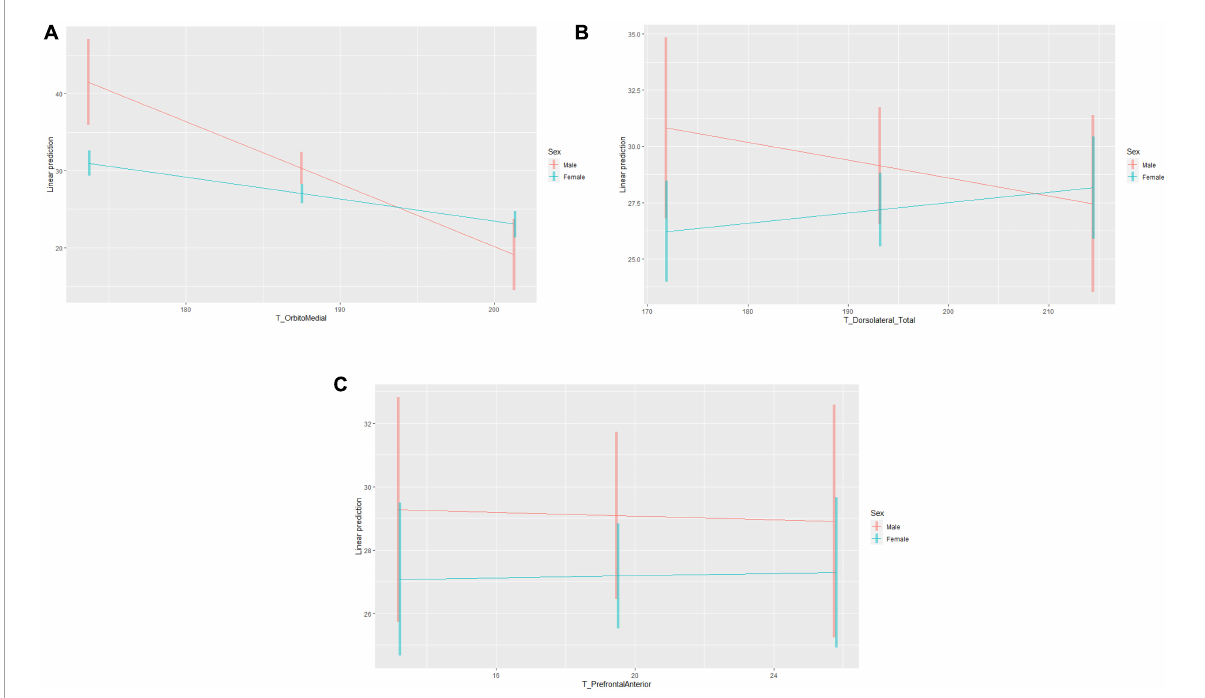
FIGURE2 Moderating effect of the sex of the students on the relationship between the executive functions and academic procrastination. (A) Moderating effect between the orbitomedial cortex and academic procrastination. (B) Moderating effect between the dorsolateral prefrontal cortex and academic procrastination. (C) Moderating effect between the anterior prefrontal cortex and academic